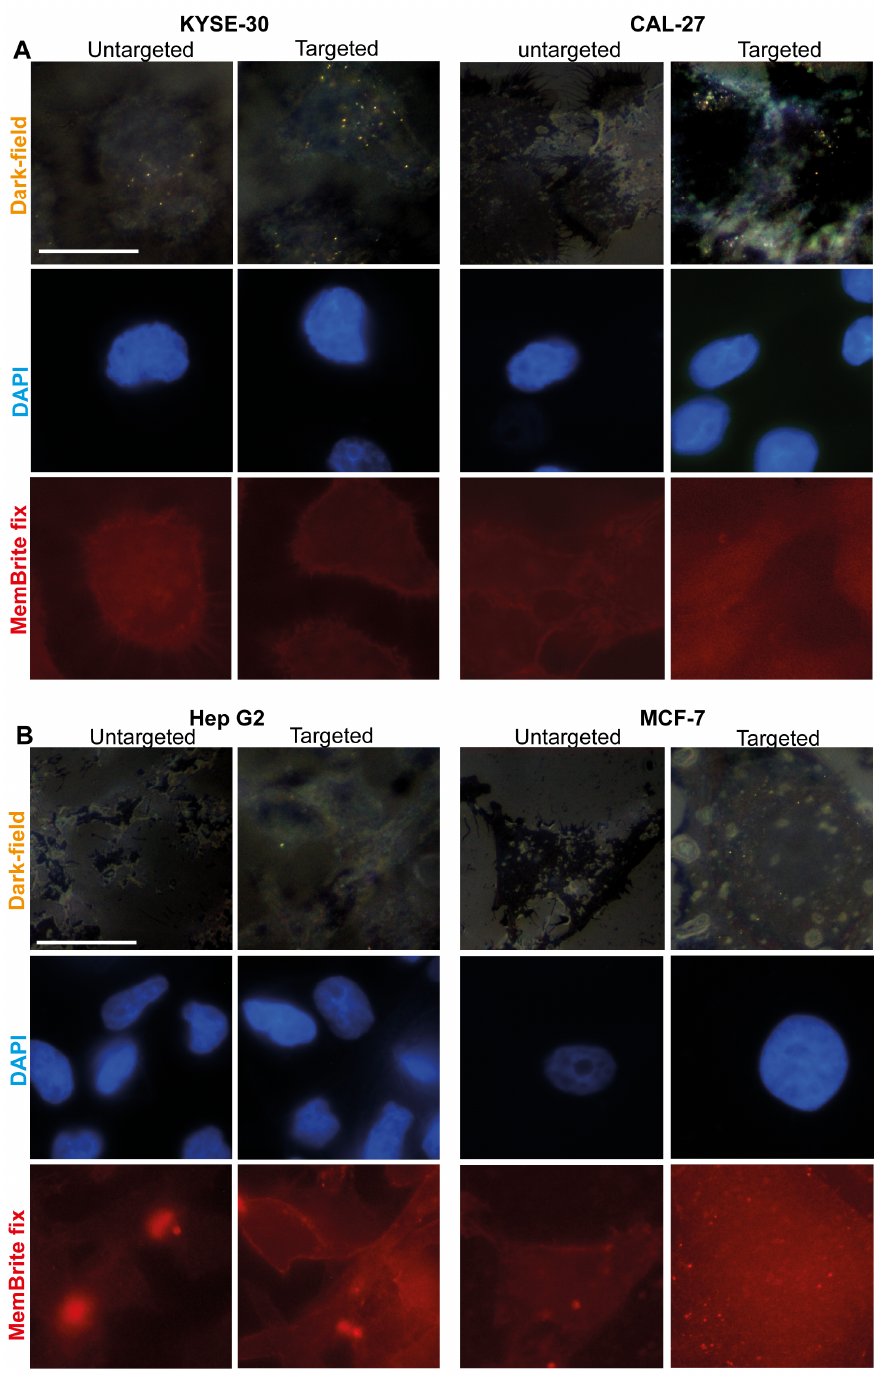
Figure 4. Images showing different intensities of AuNRs signals in EGFR-positive and negative can- cer cell lines. Dark-field, DAPI and Texas Red images of ( A ) EGFR-positive cancer cell line KYSE-30 and CAL-27 and ( B ) EGFR-negative cancer cell lines Hep G2 and MCF-7 were taken for both tAuNRs and uAuNRs groups. All dark-field (where bright yellow-to-orange colour aggregates rep- resent AuNRs), DAPI and Texas Red (MemBrite fix) images were captured using an inverted Nikon microscope with a uniform setting throughout. Scale bar, 200 µm.